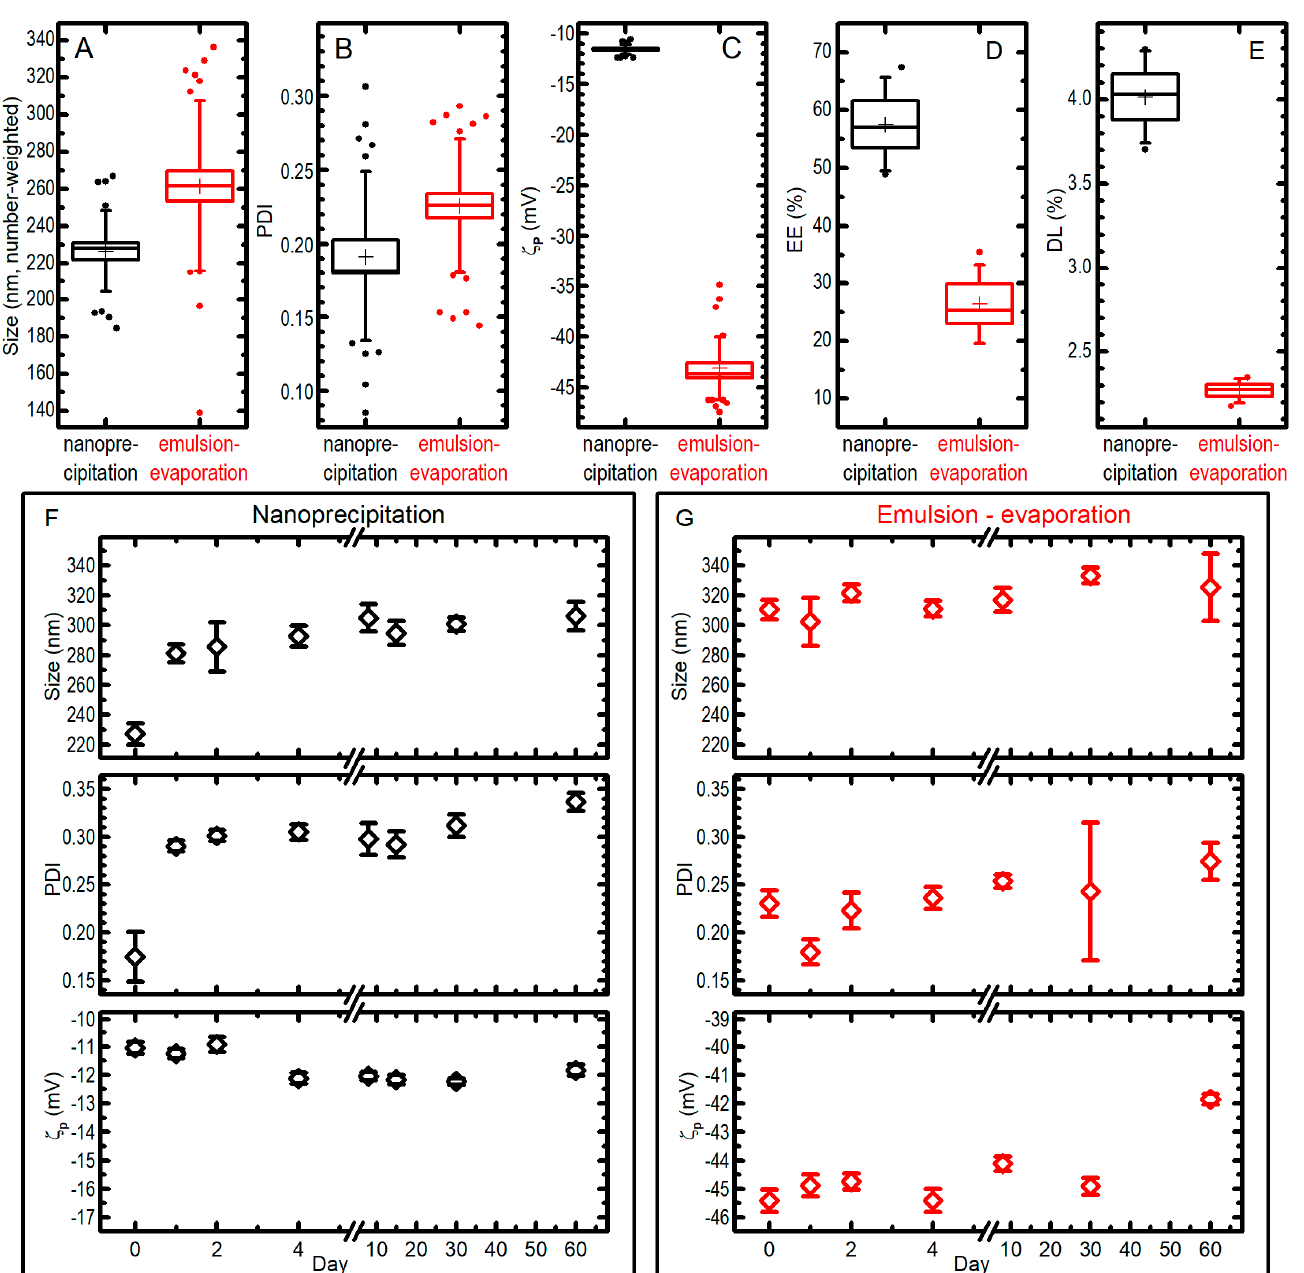
Figure 4. The best synthetic formulations for nanoprecipitation (black data) and single emulsion– solvent evaporation (red data) techniques were compared for size ( A ), PDI ( B ), ζ p ( C ), entrapment efficiency EE% ( D ), drug loading DL% ( E ). In the box plots, boxes are standard errors (SEs), whiskers are standard deviations, lines are medians, crosses are averages, dots are outliers; all the data from different measurements (25 for nanoprecipitation, 31 for emulsion-evaporation for panels ( A – C ); 4 for panels ( D , E )) on different syntheses (4 for nanoprecipitation and 5 for emulsion-evaporation in panels ( A – C ); 4 in panel ( D ) and 2 in panel ( E ) for both methods) are pooled together. Moreover, the behaviour of size, PDI, and ζ p for a single preparation of PGZ-NPs via nanoprecipitation ( F ) or single emulsification-solvent evaporation ( G ) when kept at − 20 °C for a different number of days is presented and compared with the ones of an aliquot of the fresh-prepared colloid (data at day 0); bars are SEs over 7–10 measurements. The nanoparticles developed via the nanoprecipitation method (B) had a mean di- ameter of 226 ± 22 nm (note: in this paragraph the uncertainties are standard deviations from all measurements pooled together; see Figure 4) and a very narrow size distribution